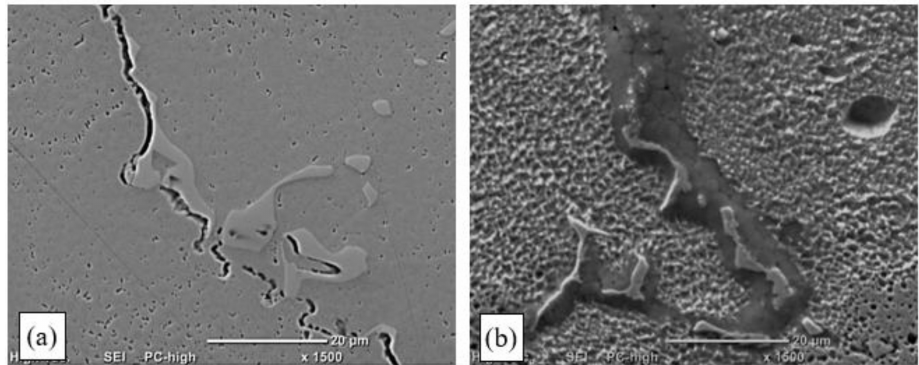
Figure 14. Padding-weld structure in TIG pad welding of Inconel 713C in a TecLine 8910 atmosphere (E l = 0.35 kJ/mm) with filler material: ( a ) crack at a dendrite/carbide interface; ( b ) microcrack along dendrite boundaries with a visible privileged trajectory determined by